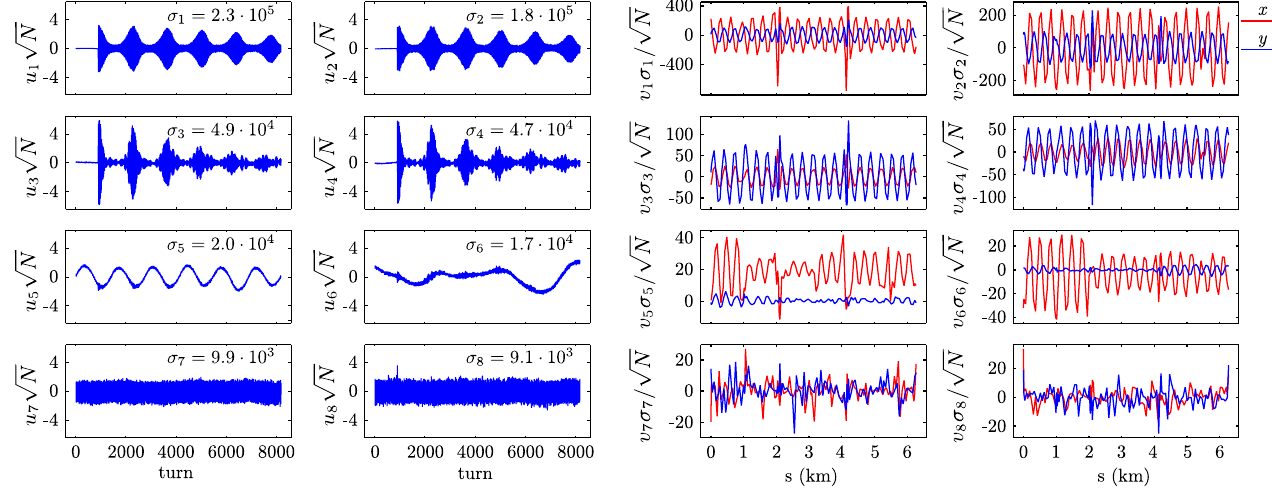
FIG. 3. Temporal (left) and spatial (right) modes of MIA corresponding to the largest eight singular